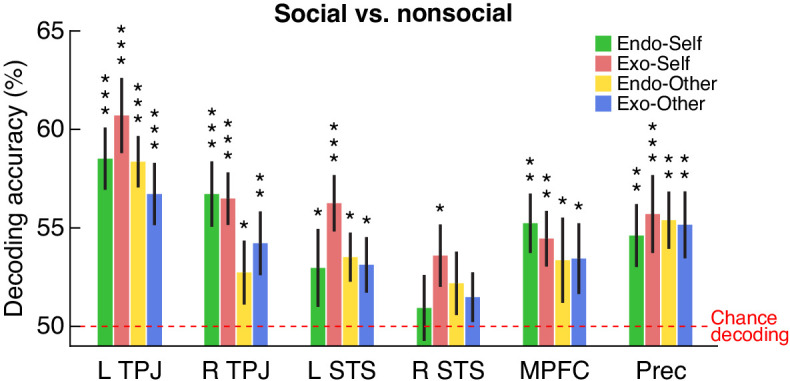
Decoding social versus nonsocial stories.The ability of a classifier, trained on BOLD activity patterns within each of the six ROIs, to decode each of the four social story conditions (endogenous-self, exogenous-self, endogenous-other, and exogenous-other) versus the nonsocial control. Each bar shows mean decoding accuracy, error bars show SEM, red horizontal line shows chance level decoding. Significance indicated by * (p<0.05), ** (p<0.01), and *** (p<0.001) based on permutation testing (all but one of the significant p values also survived FDR correction for multiple comparisons across all six ROIs; see Table 3 for numerical details).